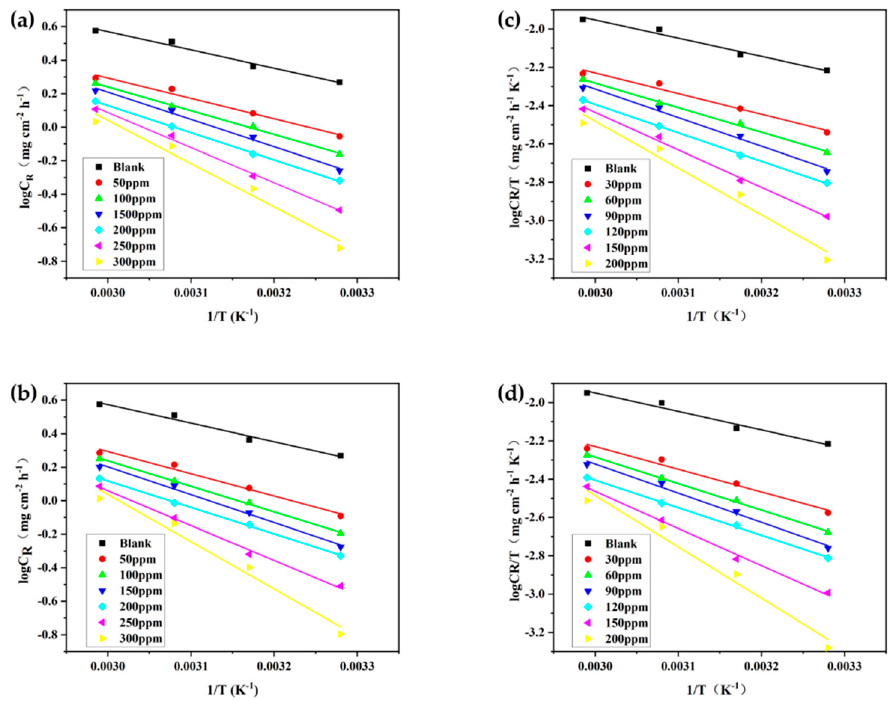
Figure 2. Arrhenius ( a ) MPO, ( b ) MPPO and Eyring ( c ) MPO, ( d ) MPPO plots for corrosion of N80 steel in 1 M HCl containing various concentrations of inhibitors.